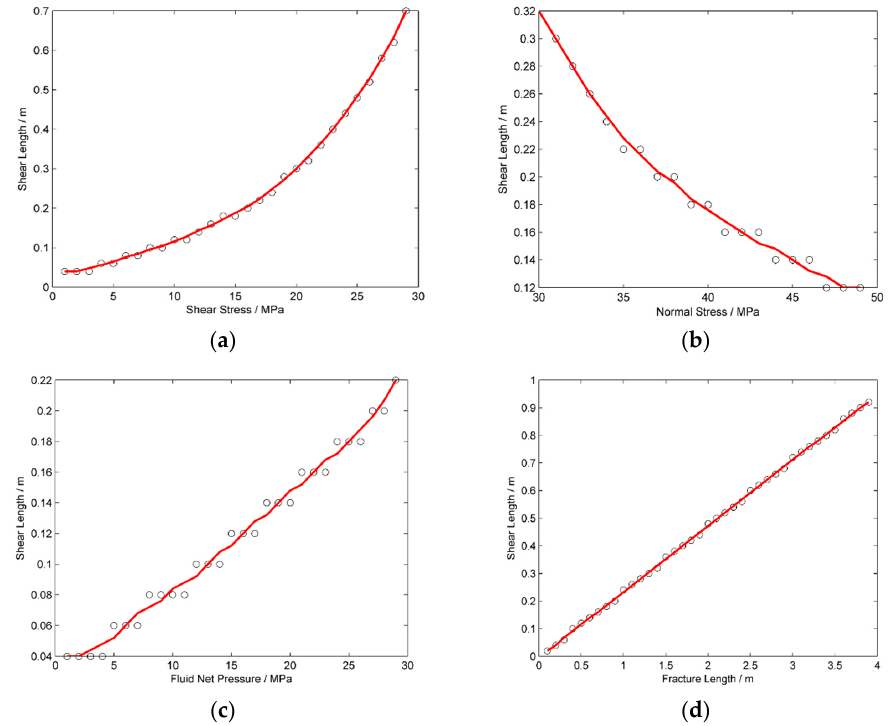
Figure 7. The variations of the length of the shear fracture that is not affected by fluid pressure with ( a ) the shear stress along the natural fracture; ( b ) the normal stress perpendicular with the natural fracture; ( c ) the fluid net pressure and ( d ) the length of the fracture part that is filled by fluid.